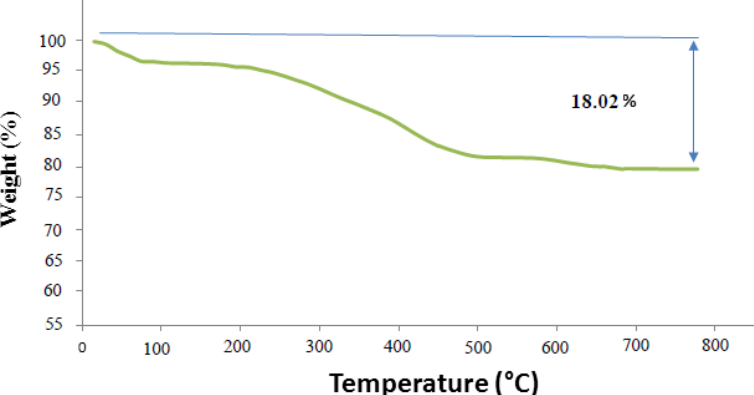
Fig. 7. TGA of Co